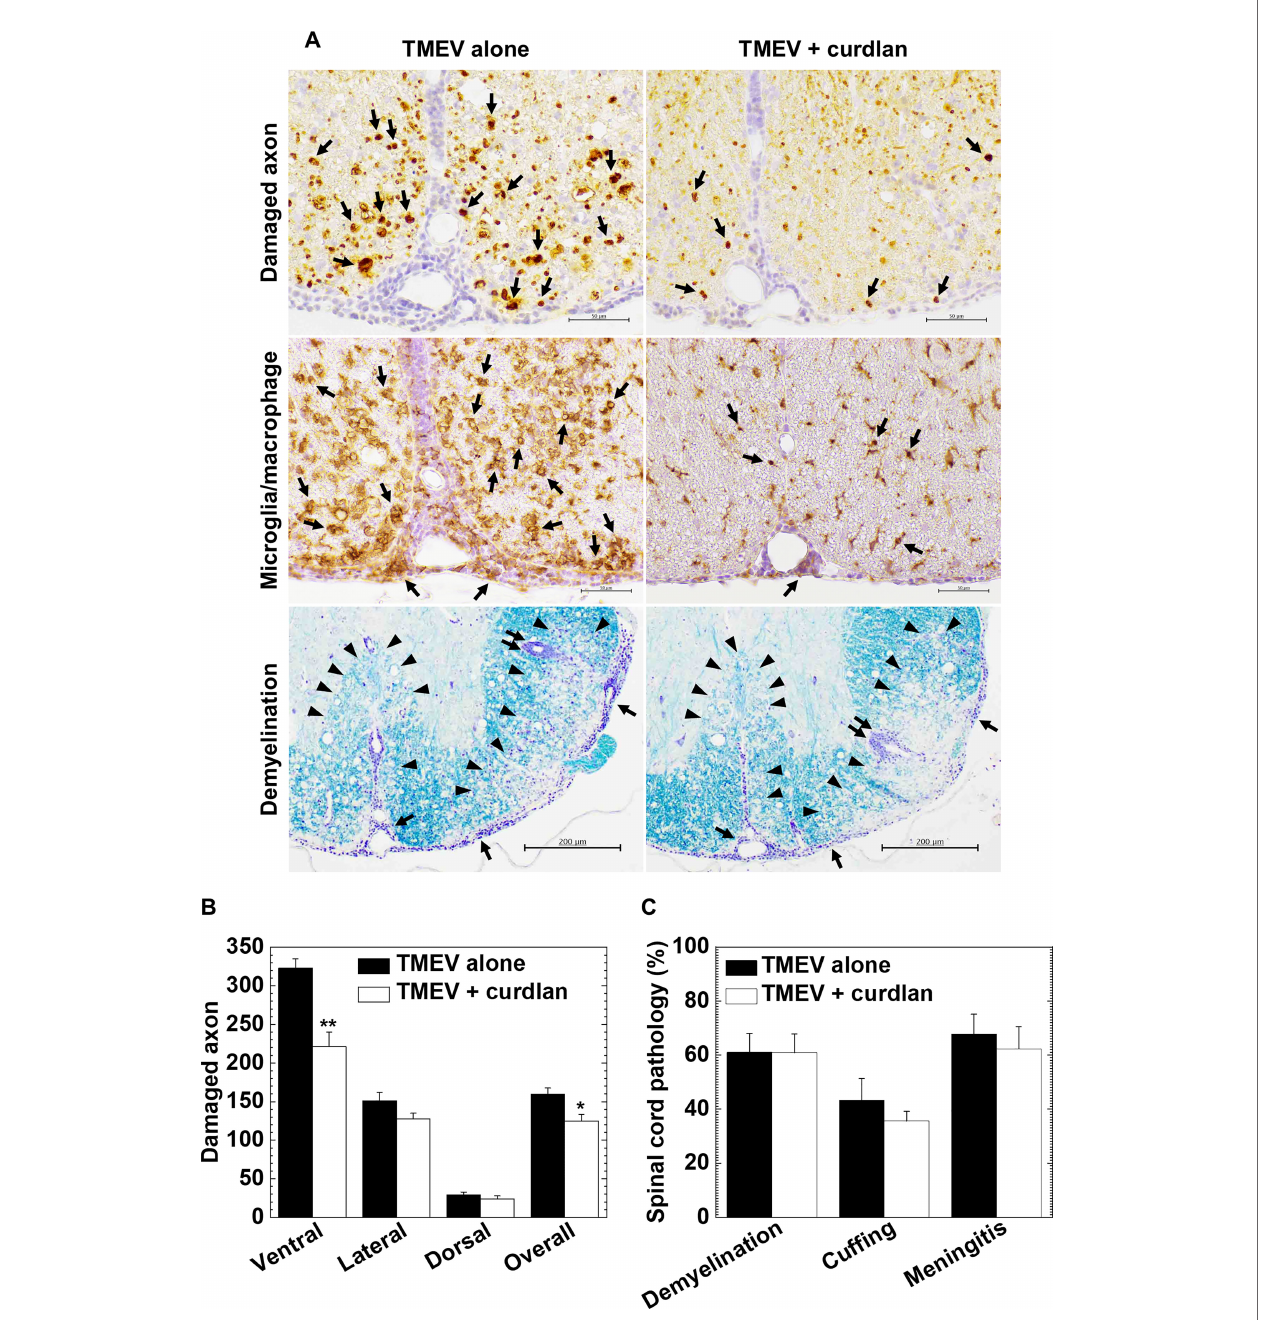
FIGURE 4 | Curdlan treatment suppressed axonal damage, but not in fl ammatory demyelination, in TMEV-IDD. (A) In the curdlan treatment group, we observed fewer damaged axons (top panels) and activated macrophages/microglia (middle panels), compared with the control group. On the other hand, the levels of in fl ammation and demyelination were similar between the two groups (bottom panels). Immunohistochemistry against non-phosphorylated neuro fi laments (top panels) and Iba1 (middle panels), and myelin stain by Luxol fast blue (bottom panels), using spinal cord sections from the control mice and curdlan-treated mice 5 weeks p.i. In immunohistochemistry (scale bar = 50 m m), arrows indicate damaged axons (top panels) and microglia/macrophage activation (middle panels). In Luxol fast blue stain (scale bar = 200 m m), arrowheads, paired arrows, and arrows indicate demyelination, perivascular cuf fi ng (in fl ammation), and meningitis, respectively. Tissue sections are representative from three independent experiments (four mice per group per experiment). (B, C) We quanti fi ed the number of damaged axons per spinal cord quadrant (B) and neuropathology scores (C) of the spinal cord in the TMEV alone (black bar) and TMEV + curdlan groups (white bar) 5 weeks p.i. The TMEV + curdlan group had less damaged axons in the spinal cord, particularly in the ventral funiculus, compared with the TMEV alone group, although the pathology scores of demyelination, perivascular cuf fi ng (in fl ammation), and meningitis were similar between the two groups. Values are the mean + SEM of four mice per group. * P < 0.05 and ** P < 0.01, Student ’ s t